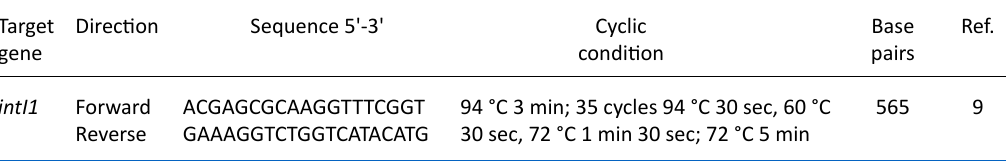
table 2. The primer sequence used for the detection of class 1 integron Target